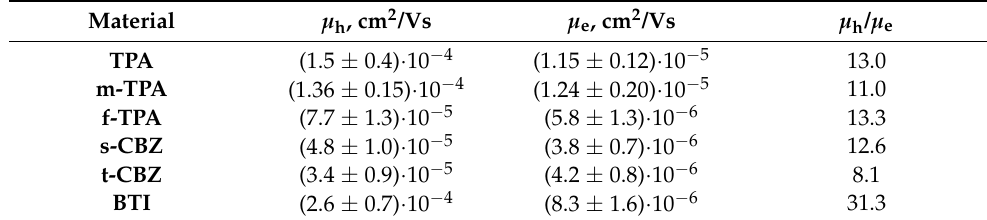
Table 4. Hole ( µ h ) and electron ( µ e ) mobilities in pristine films.